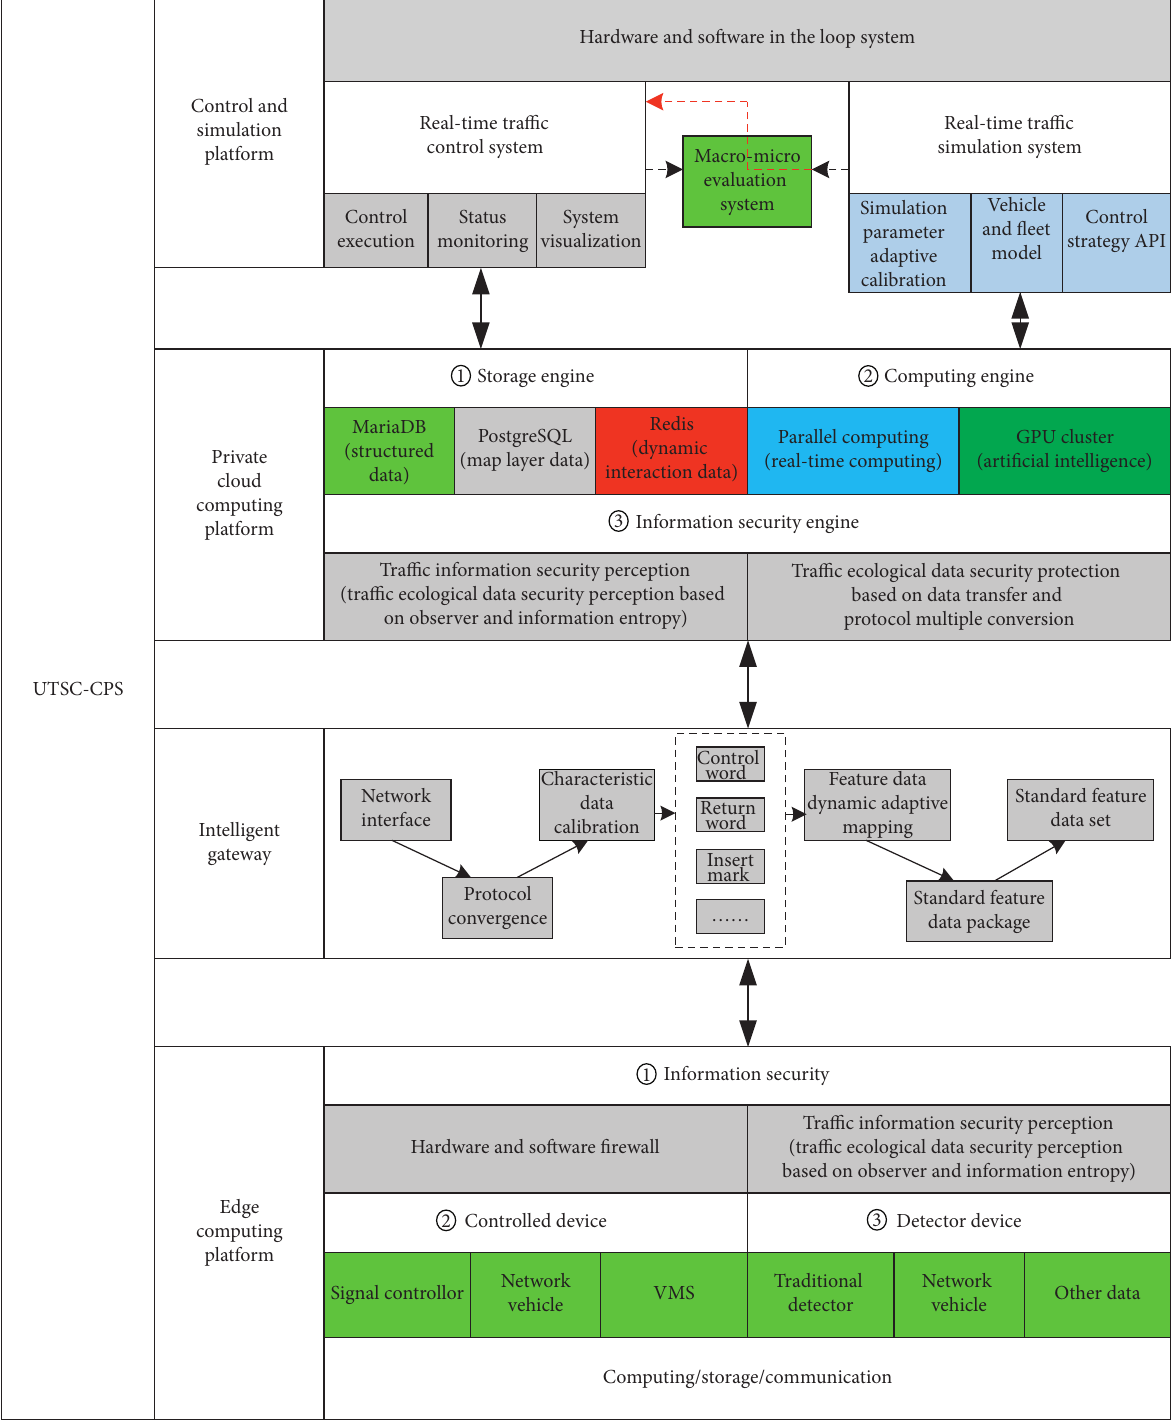
Figure 2: System architecture of the “UTSC-CPS” urban road traffic signal control